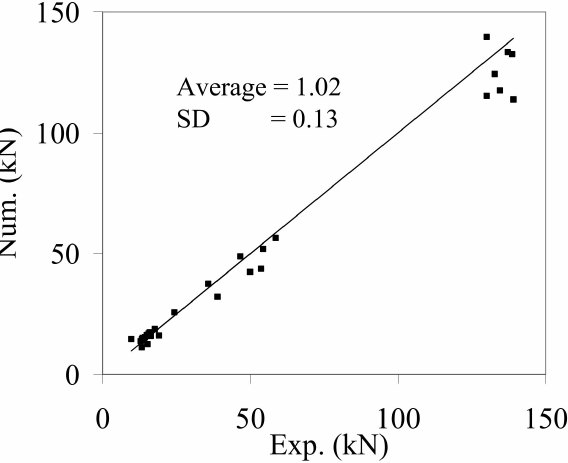
Figure 11. Comparison between the experimental and numerical maximum load. For the modified beam specimens, two failure modes, namely CFRP debonding and flexural failure, were expected to govern the ultimate capacity of the NSM CFRP- strengthened modified beams. In the finite element simulations, the CFRP debonding load was determined when the slip values in the horizontal interface elements connecting the CFRP strips and concrete nodes reached the maximum value (interface element group